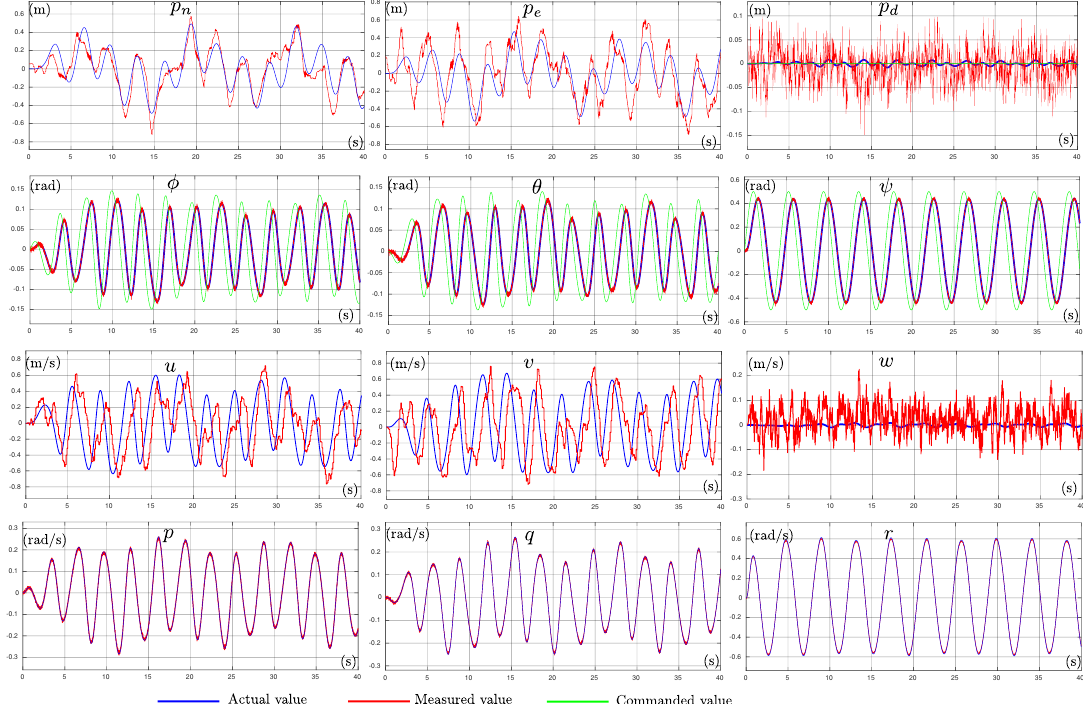
Figure 4. Control reference signals (green). Actual quadrotor states (blue). Measured quadrotor states